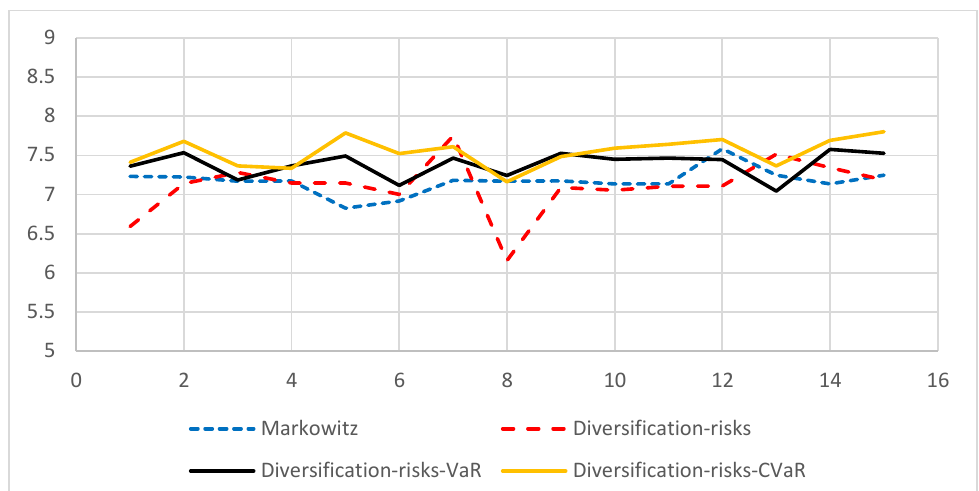
Figure 6. Average of stock returns in different iteration using four